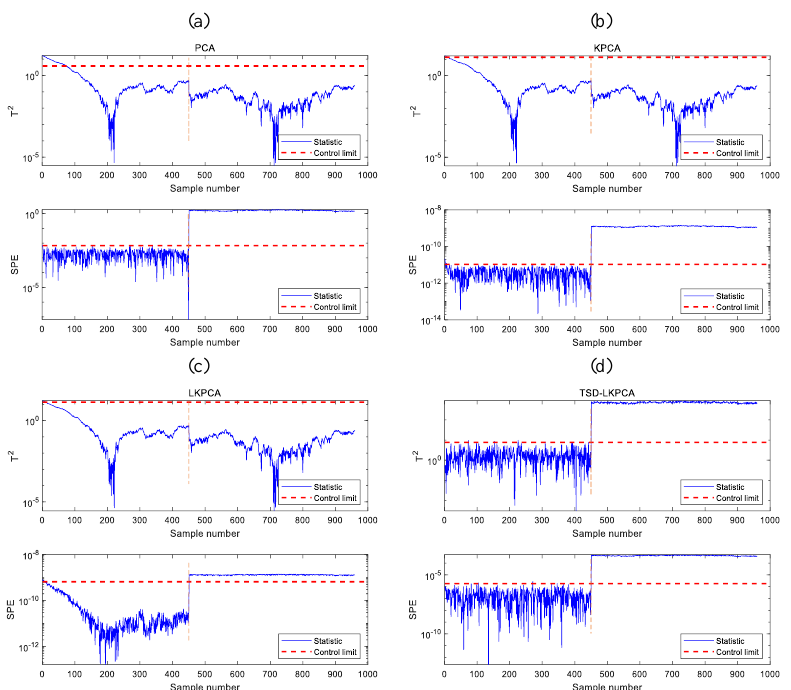
Figure 5. Monitoring charts of fault 2 in the numerical example: ( a ) PCA, ( b ) KPCA, ( c ) LKPCA ( d ) TSD-LKPCA